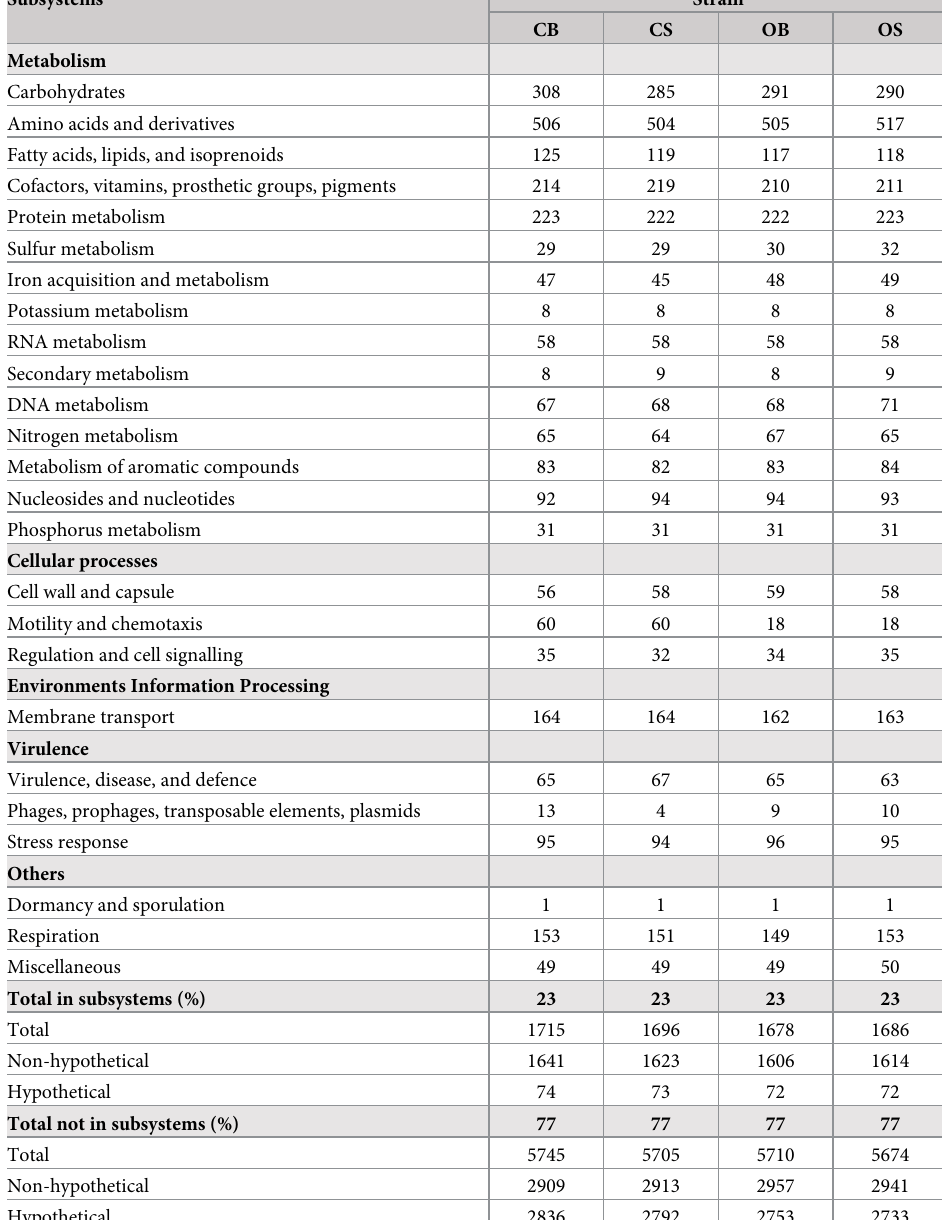
Table 3. A list of subsystems and the number of CDSs corresponding to each subsystem of four Burkholderia pseudomallei draft